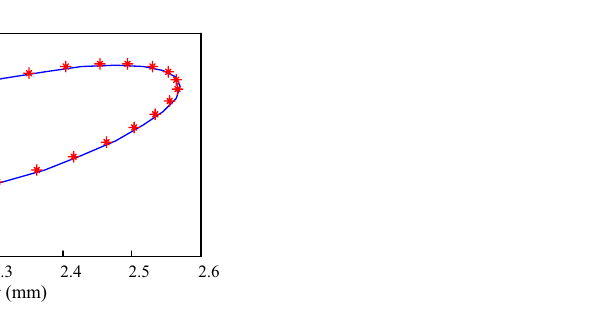
Figure 12. Comparison between the measured results and the prediction